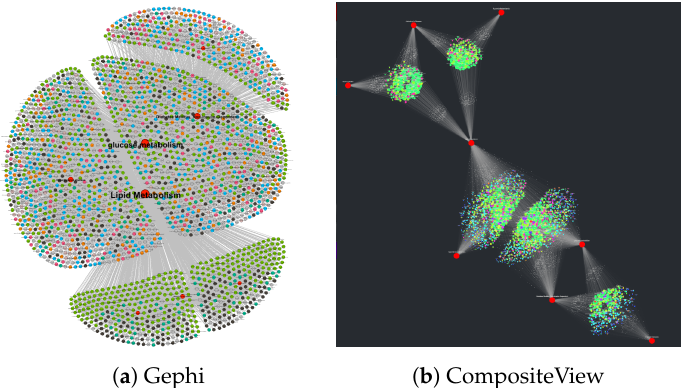
Figure 14. Visual comparison between Gephi and CompositeView using the same SemNet data set seen in Figures 3 and 4 (approximately 2472 source nodes). The red circles represent the main input features or nodes for which relationships are being visualized. In this example, visualized relationships for composite data are much easier to deduce with CompositeView compared to